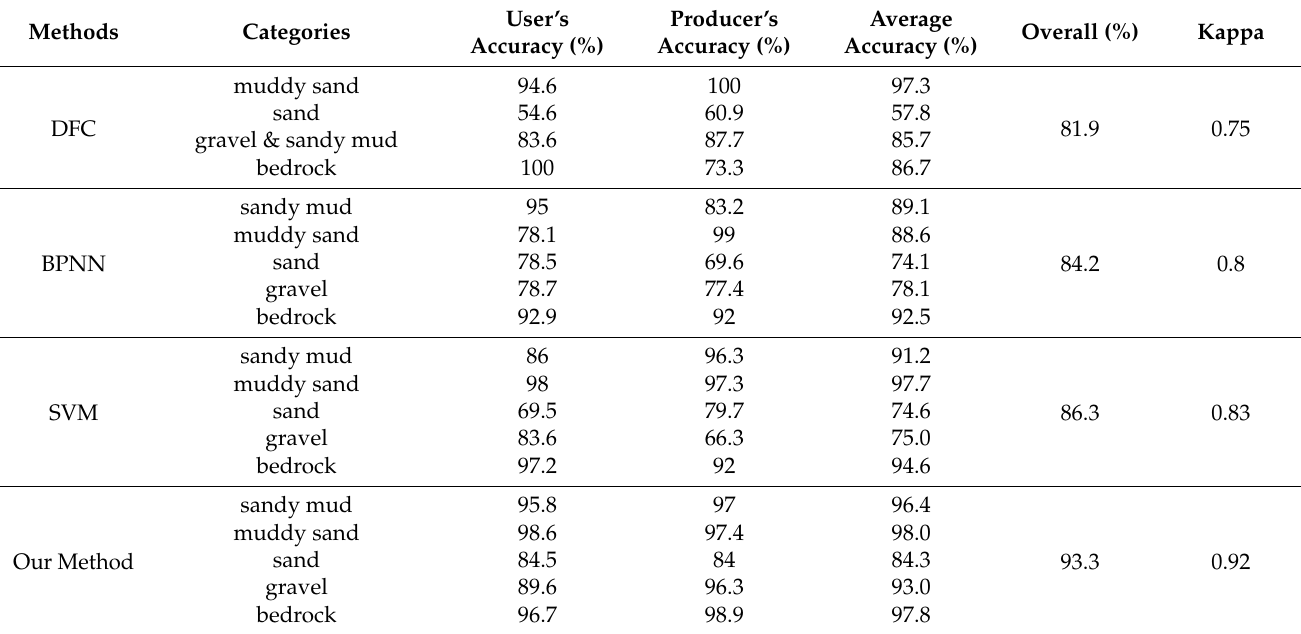
Table 5. Classification accuracy of different classifiers.